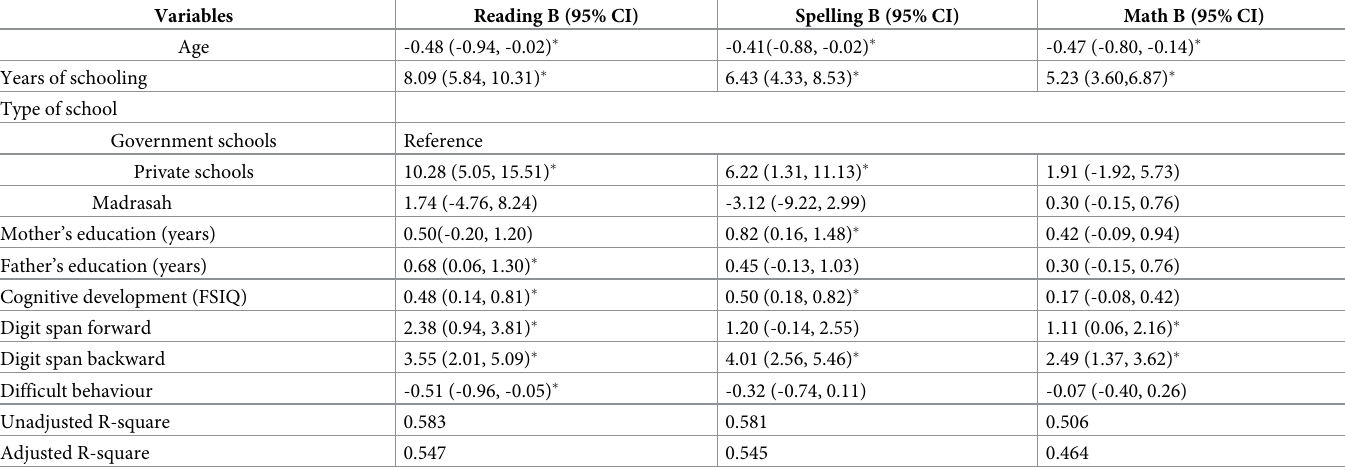
Table 5. Adjusted multiple linear regression analysis of background characteristics, anthropometry indices and developmental status of the children on the school